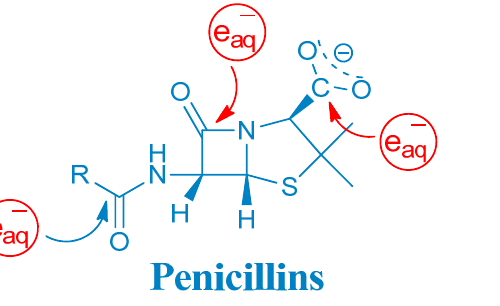
Scheme 3. Hydrated electron attack on the penicillins’